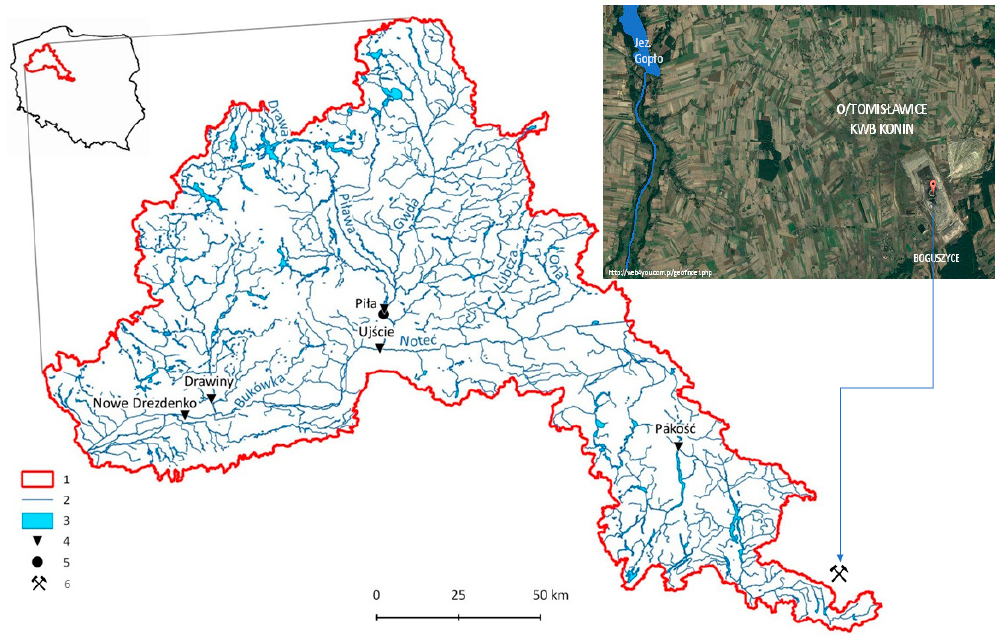
Figure 1. Location of the Note ć catchment and distribution of river water temperature and air temperature measurement stations in the study area: (1) catchment boundary, (2) river, (3) lake, (4) water measurement station, (5) air measurement station, (6) the Tomisławice lignite exposure owned by the Konin coal mine (outside the research area).